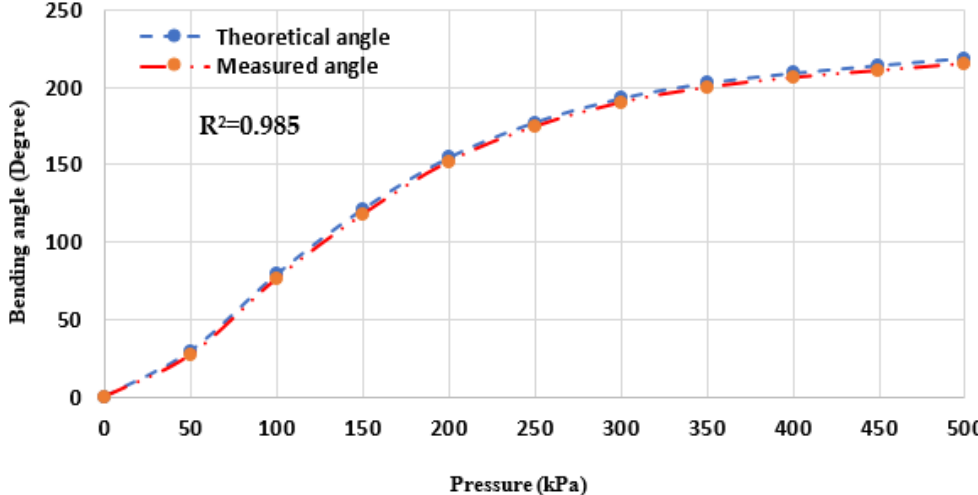
Figure 10. The bending angle of the 30 cm SBCA.